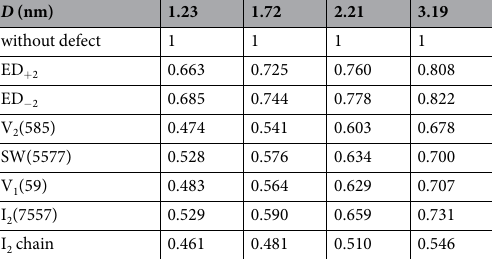
Table 1. Dependence of the average transmission coefficient of phonons T on the nanoribbon width D and a type of